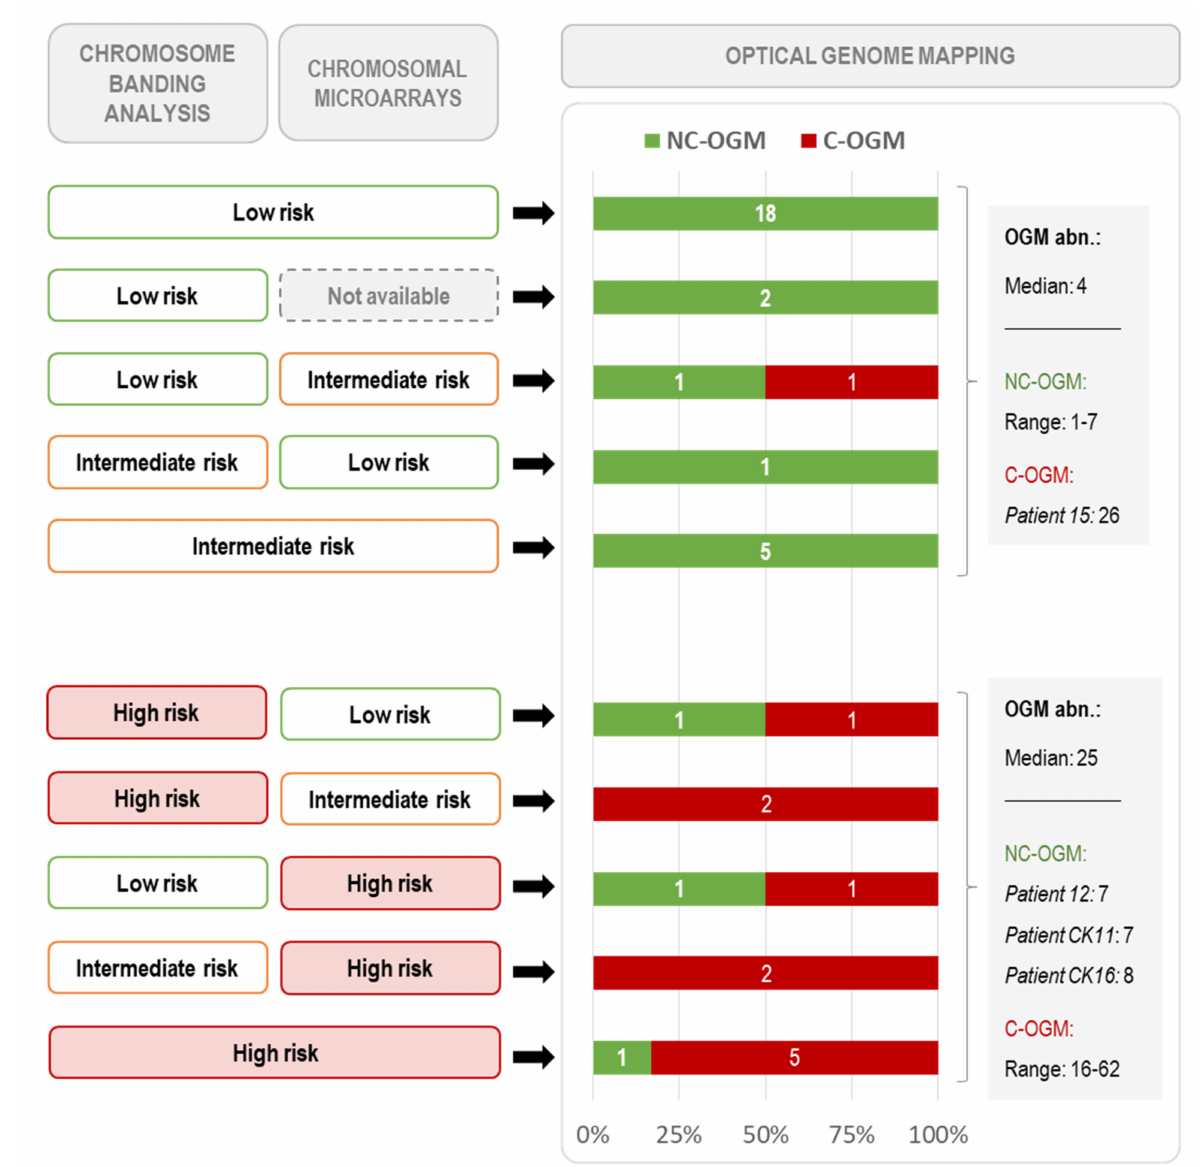
Figure 4. Patient distribution based on genomic complexity risk stratification by CBA, CMA and OGM. CBA and CMA categories were defined as described in previous studies (Ramos-Campoy et al., 2022): Low risk (0–2 abnormalities), Intermediate risk (3–4 abnormalities) and High risk ( ≥ 5 abnor- malities). Patients were divided into two categories based on OGM results: NC-OGM (Non-complex by OGM, <10 abnormalities) and C-OGM (Complex by OGM, ≥ 10 abnormalities). Each line rep- resents one possible combination of the risk assigned by CBA and/or CMA (depicted on the left), for the OGM results (right) the number of patients classified into each category is plotted and the number of abnormalities recorded is detailed in the gray boxes. Globally, for the identification of high-risk patients, a moderate-strong agreement was observed between OGM and the combination of CBA and CMA methods ( κ = 0.778; p <